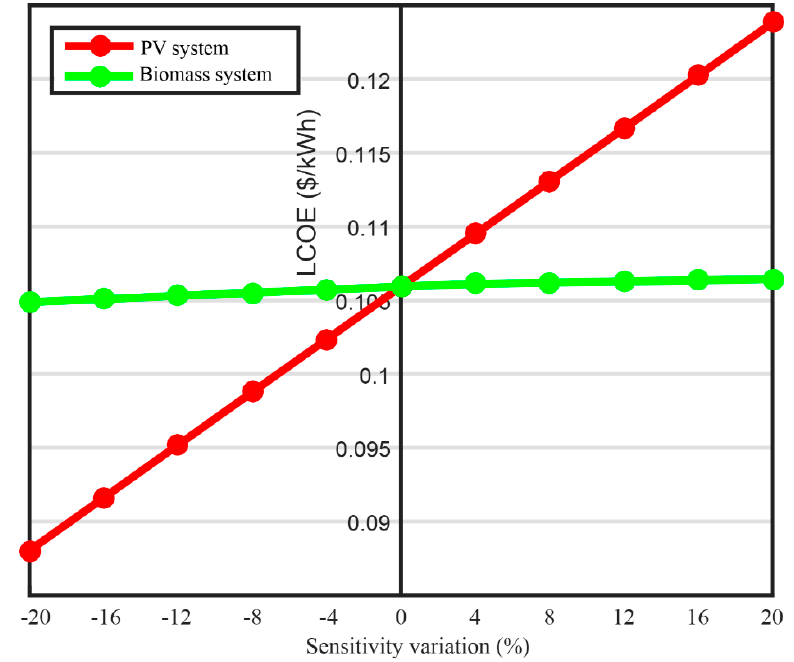
Figure 12. Sensitivity analysis application for Levelized Cost of Energy (LCOE).